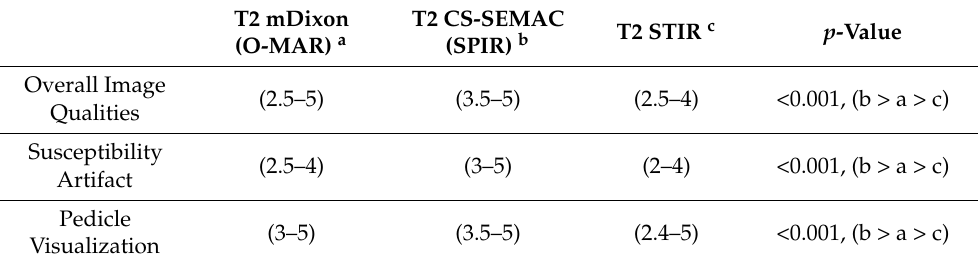
Table 7. Result of qualitative analysis of T2 Fat Suppression MAR effect when tested with transplant patients